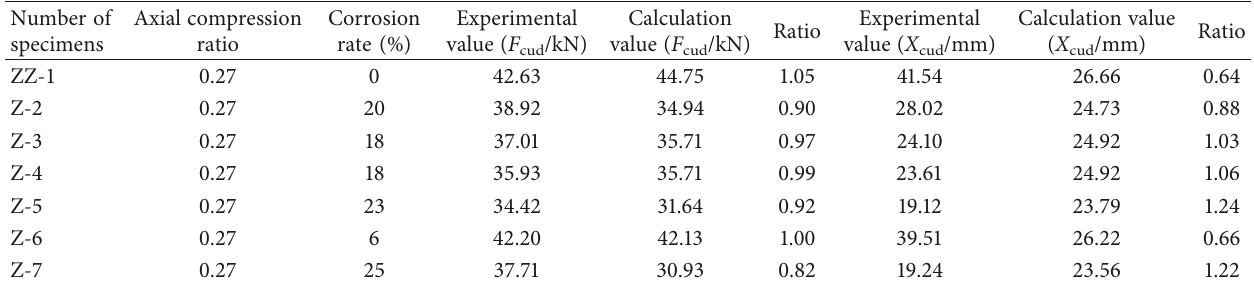
Table 5: The comparison between theoretical value and experimental